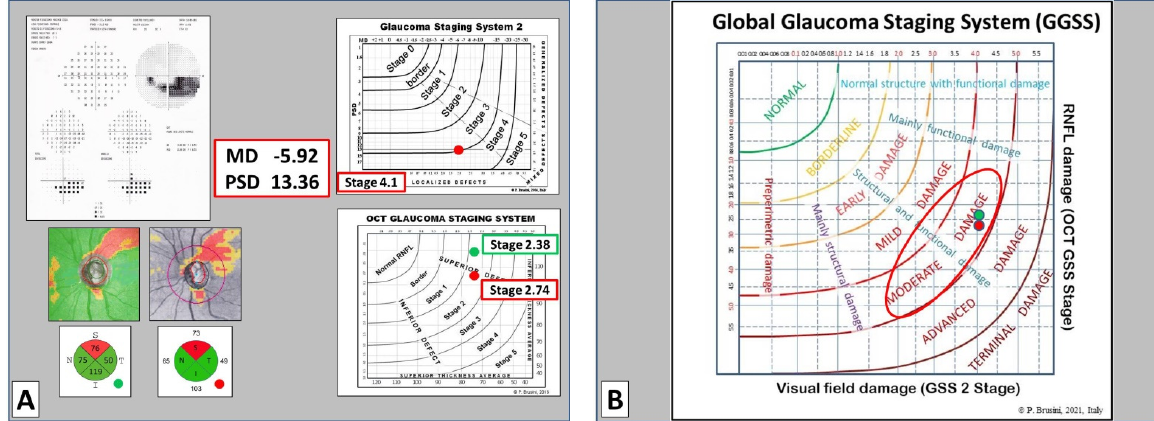
Figure 6. ( A ) 63 year old man with pseudoesfoliation glaucoma with a deep inferior arcuate scotoma (GSS 2 Stage 4.1); two different OCTs (Nidek RS-3000 on the left and Zeiss Cirrus on the right) show similar superior nerve fiber defect (OCT GSS Stage 2.38 and 2.74, respectively). Clinical classification: Stage 3; ( B ) the GGSS classifies this patient as having a moderate global damage with structural and functional loss.